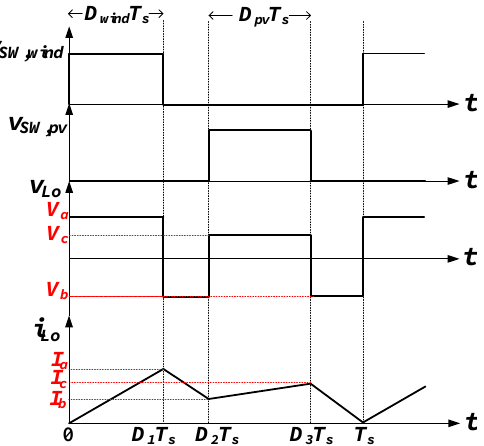
Figure 6. The waveforms for the understanding of inductance derivation.